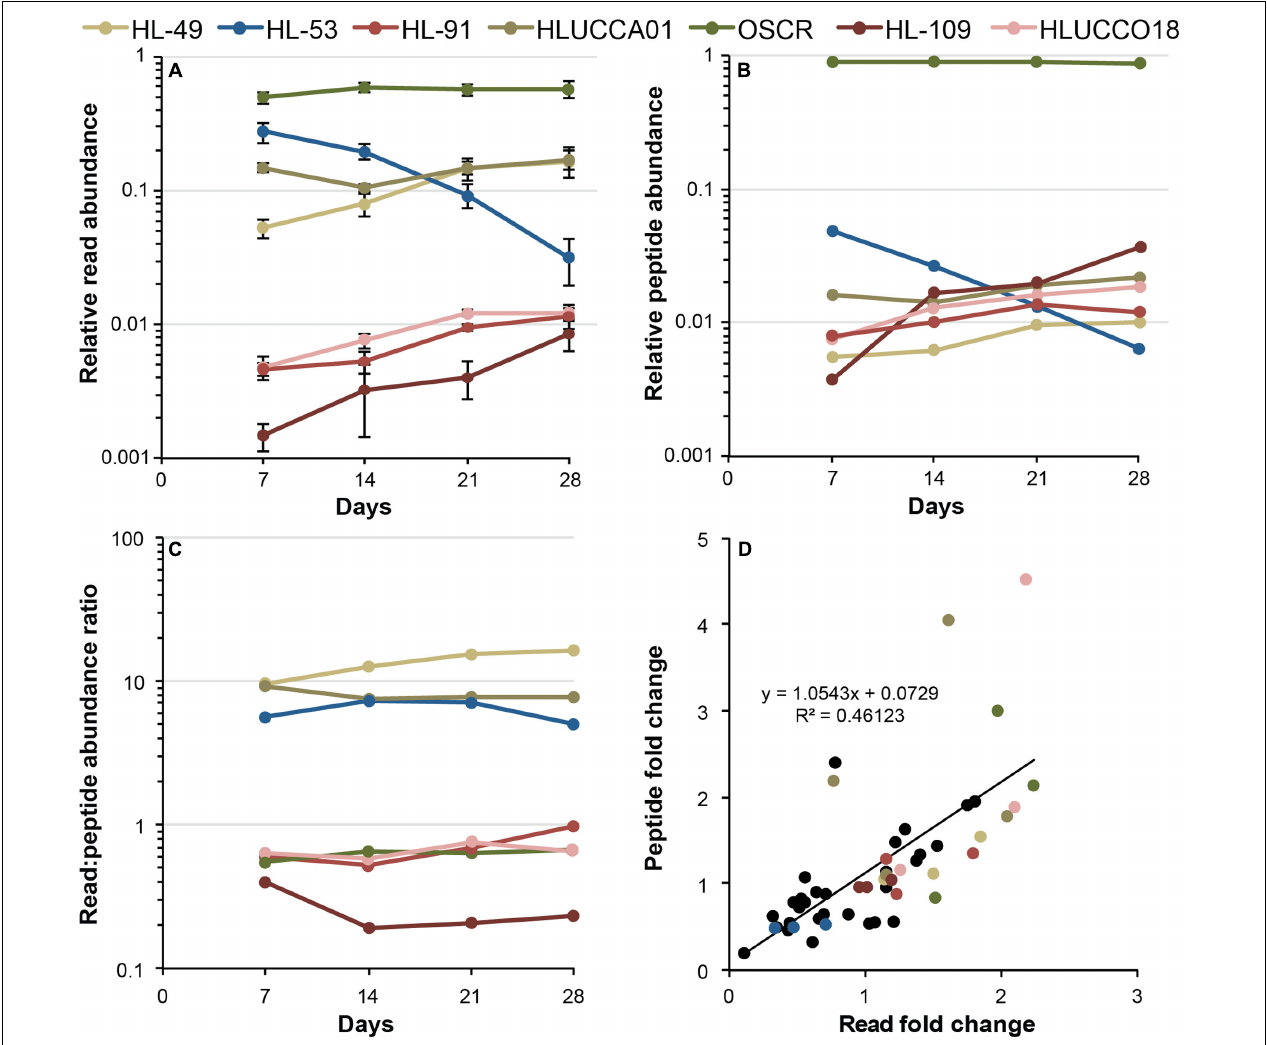
FIGURE 2 | Metatranscriptomic and metaproteomic measures of member activity dynamics. (A) Metatranscriptomic measurement of member activity during succession, represented as the fraction of the total reads per sample attributed to each organism. Values are plotted on a log 10 scale, error bars denote the 95% confidence interval of the mean. (B) Metaproteomic evaluation of member activity during succession, represented as the share of peptide spectral counts attributed to each of the members. Values are plotted on a log 10 scale. Error bars are omitted for clarity, but variance data are presented in Supplementary Table S3 . (C) Ratio of member relative activity as assessed by metatranscriptomics to that observed by metaproteomics during succession. Flat lines ( m = 0) indicate a monotonic relationship between metatranscriptomic and metaproteomic estimations. (D) Organism-centric changes in metatranscriptomic and metaproteomic estimates of relative activity across all members between sequential time points. The y -axis indicates the between-time point fold change in the relative abundance of an organism’s peptide spectral counts, and the x -axis indicates the fold change in an organism’s RNA read abundance. Colored dots represent the seven most dominant species according to the key, and black dots indicate fold changes for less-abundant